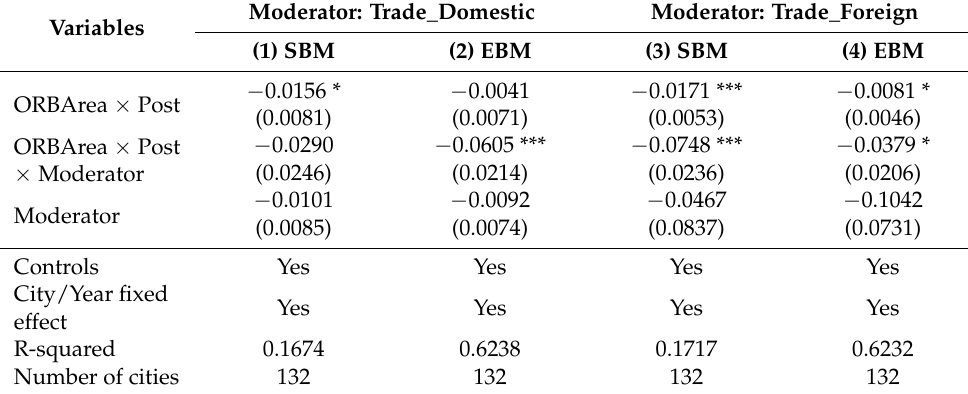
Table 11. Empirical results on the moderating effect of the trade